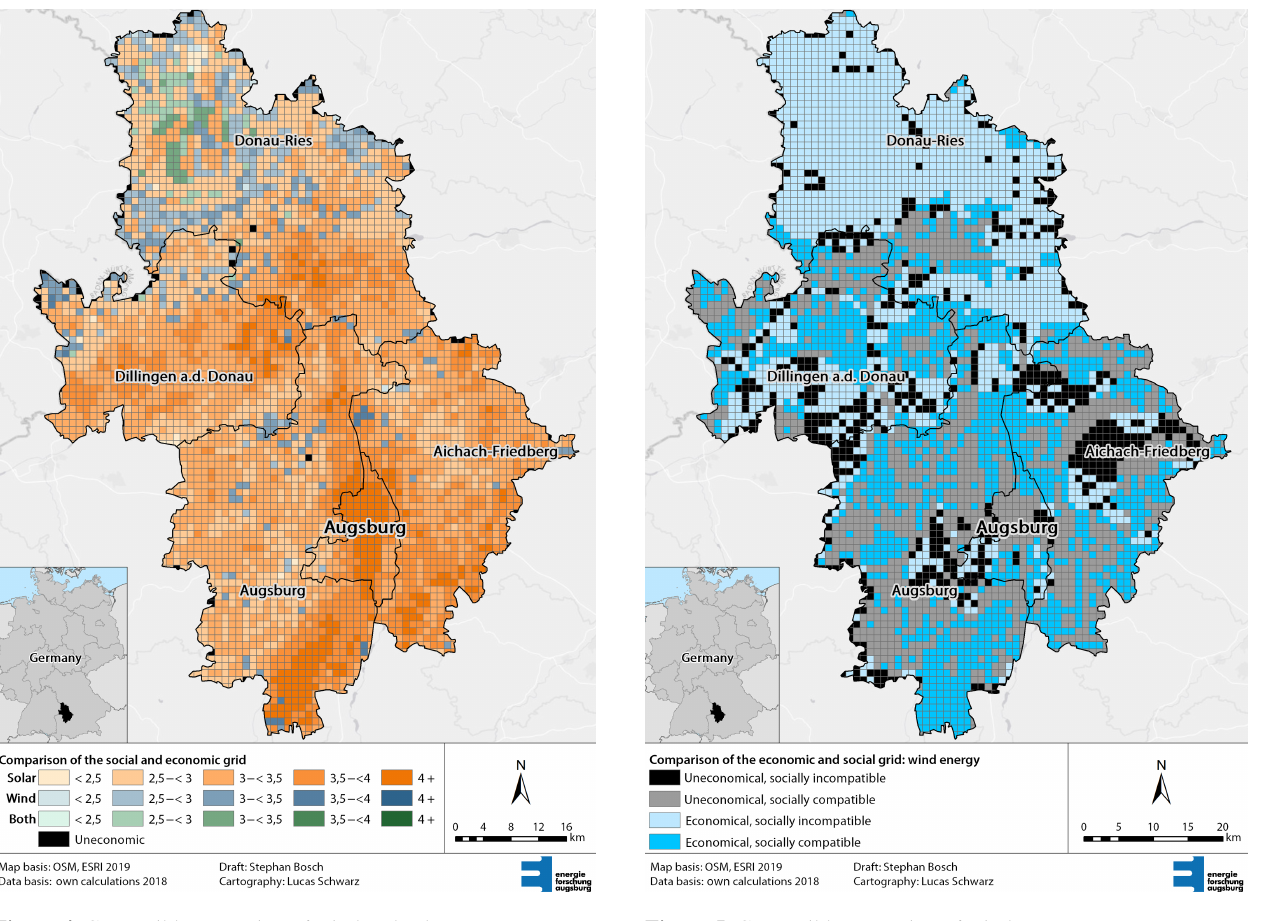
Figure 4. Compatible expansion of wind and solar energy. Figure 5. Compatible expansion of wind